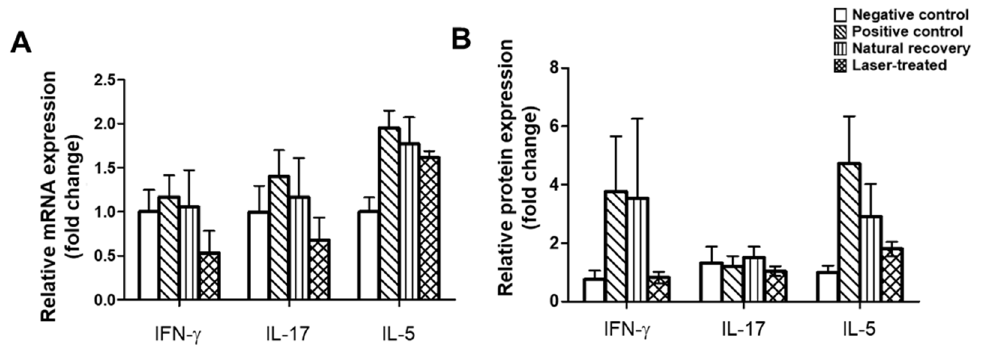
Figure 3. Local cytokine levels as determined by real-time PCR and Western blotting. ( A ) Sino-nasal mucosa RNAs were isolated and the levels of IFN- γ , IL-17, and IL-5 were measured by RT-qPCR. ( B ) Sino-nasal mucosa proteins were isolated and the levels of IFN- γ , IL-17, and IL-5 were measured by Western blotting. Graphs indicate relative protein expression levels normalized to β -actin using the densitometric analysis with Western blotting bands presented in Supplementary Figure S1. Data are expressed as the means ± SEMs.